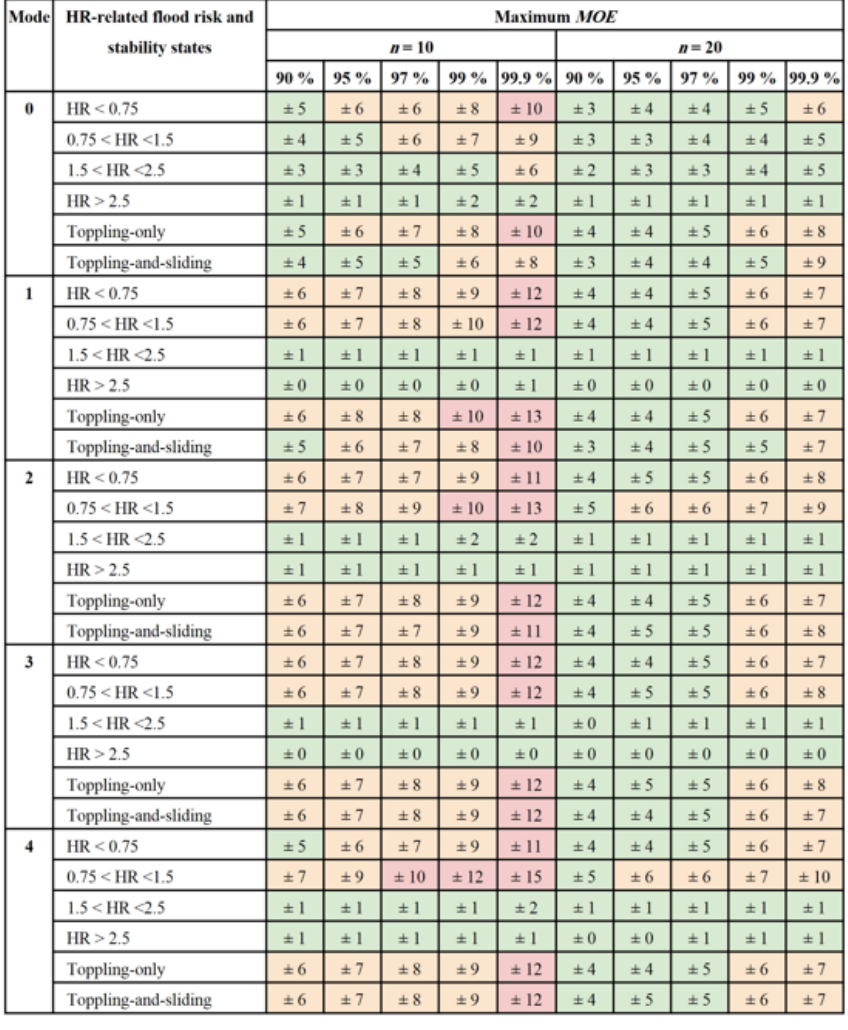
Table 5. Maximum margin of error (MOE) for the average number of pedestrian agents with different HR-related flood risk or stability states that are extracted from the recorded outputs of all the configuration modes (Table 4) and across different confidence levels ranging from 90% to 99.9%. Different ranges of the evaluated maximum MOE are highlighted with different colour shades: green, orange, and red to indicate MOE ≤ ± 5, 6 ≤ MOE ≤ 9, and MOE ≥ 10,